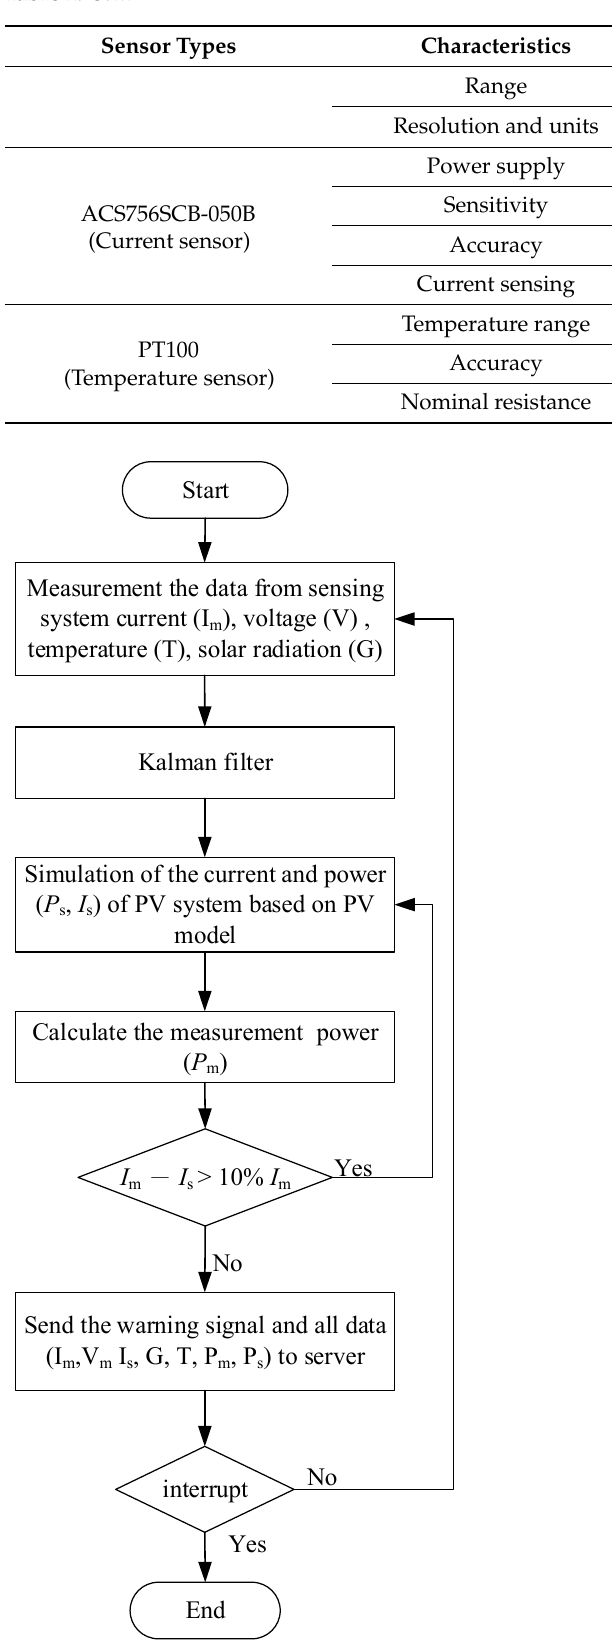
Figure 2. Flowchart of proposed IoT-based PVEFD